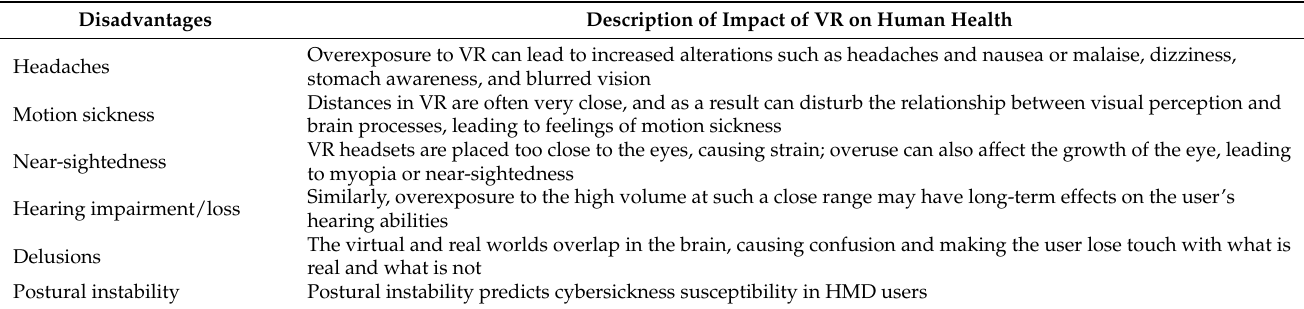
Table 3. The limitations/disadvantages of VR with regard to brain